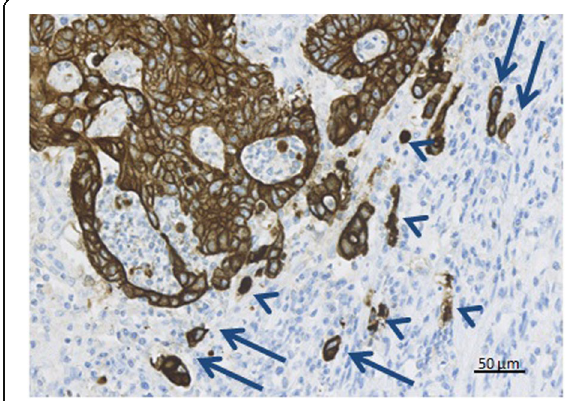
Fig. 2 Counting tumour budding in a high power field (HPF). The number of tumour buds (TB) was counted along the invasive front on cytokeratin AE1/AE3 stained sections in 10 HPF. A tumour bud was defined as an isolated single tumour cell or a cluster of up to four tumour cells (arrows). Adenocarcinoma cells without a clear nucleus and cytoplasmatic fragments (arrowheads) were not counted. Magnification